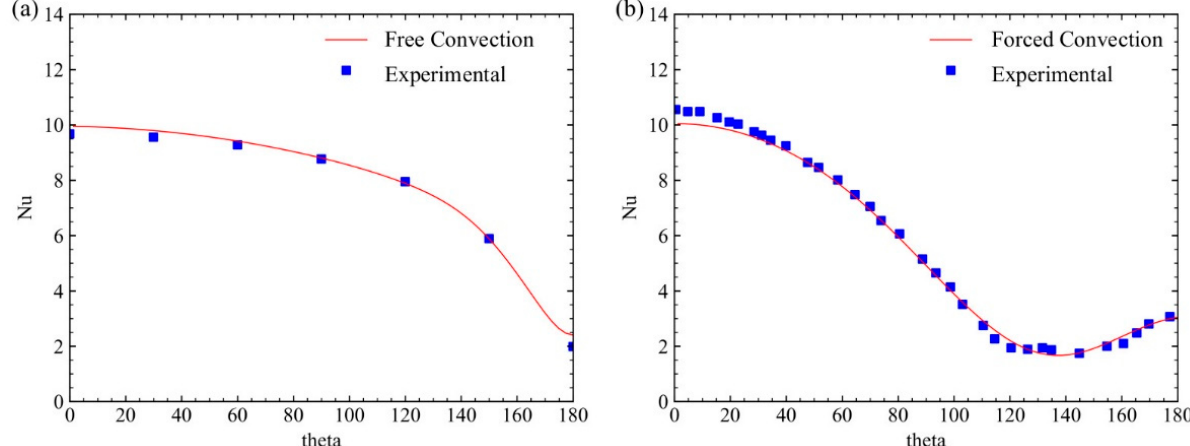
Figure 7. Comparison of the calculated and measured Nu on the pipe for ( a ) free and ( b ) forced convections.